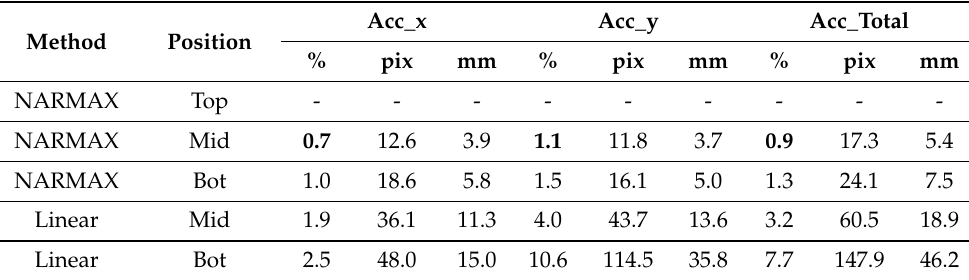
Table 2. Testing accuracy vs. camera position on a 1920 × 1080 screen. Test done by one person looking at eight points on a screen. Test was done 5 times.